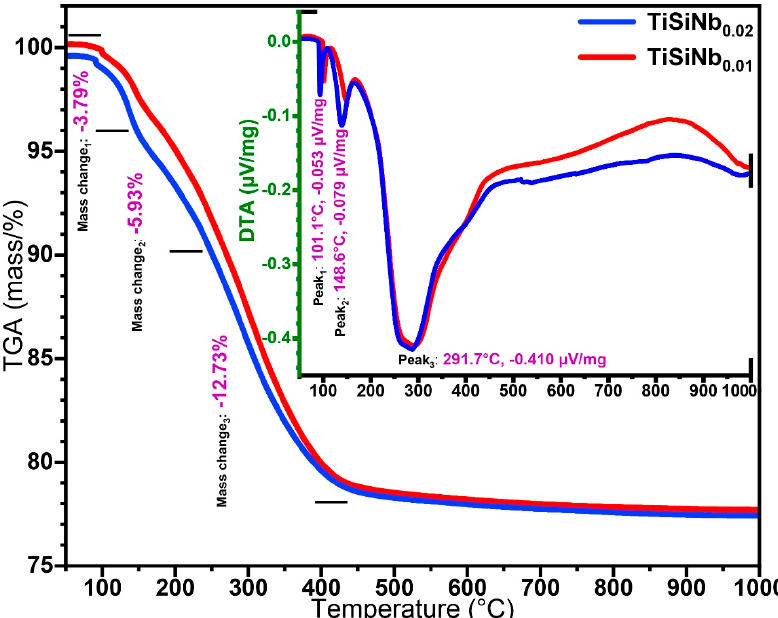
Figure 2. Thermal gravimetric analysis (TGA)-differential thermal analysis (DTA) curves of the TiSiNb dried gel at 100 °C for 12 h with different Nb contents.